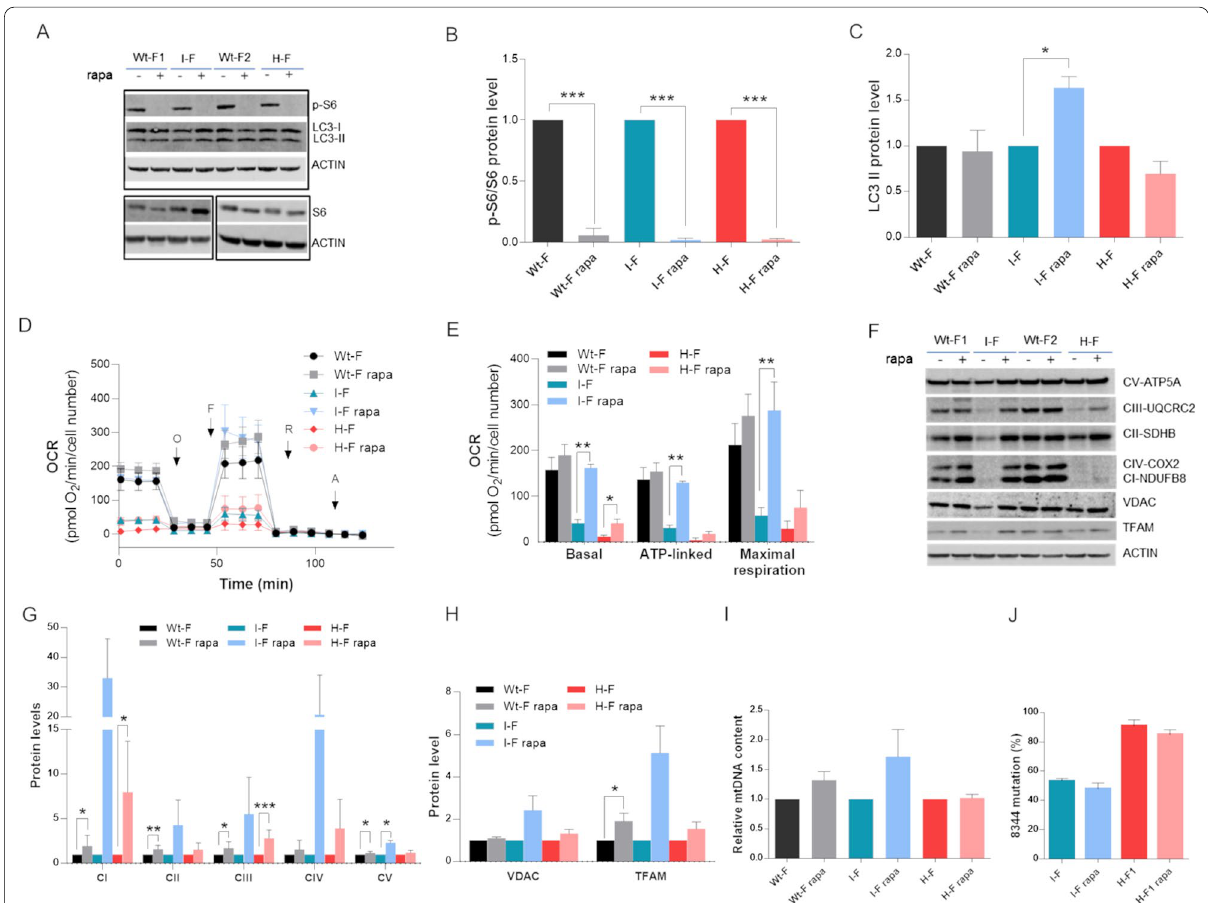
Fig. 6 Mitochondrial respiration and mass assessment in MERRF fibroblasts treated with rapamycin. Wt-Fibroblasts, I-Fibroblasts and H-Fibroblasts were treated four weeks with 20 nM rapamycin. A Representative Western Blot of p-S6, S6 and LC3 proteins. ACTIN was used ad loading control. B Densitometric analyses of downstream target of mTORC1, p-S6 protein. C Densitometric analyses of LC3-II protein. D OCR expressed as pmoles O 2 /min normalized to cell number, under basal conditions and after injection of oligomycin (O), carbonyl cyanide 4-(trifluoromethoxy) phenylhydrazone (FCCP; F), rotenone (R) and antimycin A (AA). E Basal, ATP-linked and maximal respiration were calculated from OCR traces and reported in the graph. Data are means SEM of five experiments for Wt- and H-fibroblasts and of three experiments for I-fibroblasts. F Western Blot ± analyses of OXPHOS proteins, VDAC and TFAM mitochondrial mass proteins. One representative experiment is shown. Densitometric analyses of OXPHOS G and VDAC and TFAM proteins H . I mtDNA content evaluation by qPCR. J m.8344A > G mutation heteroplasmy evaluation by SNaPshot method. All data are normalized to untreated cells and, if not specifically indicated, are means and SD of six biological replicates for Wt-F, two biological replicates for I-F and four biological replicates for H-F. Statistical analyses were performed using unpaired two-tail T-test. P value: *p < 0.05, **p < 0.01, ***p <